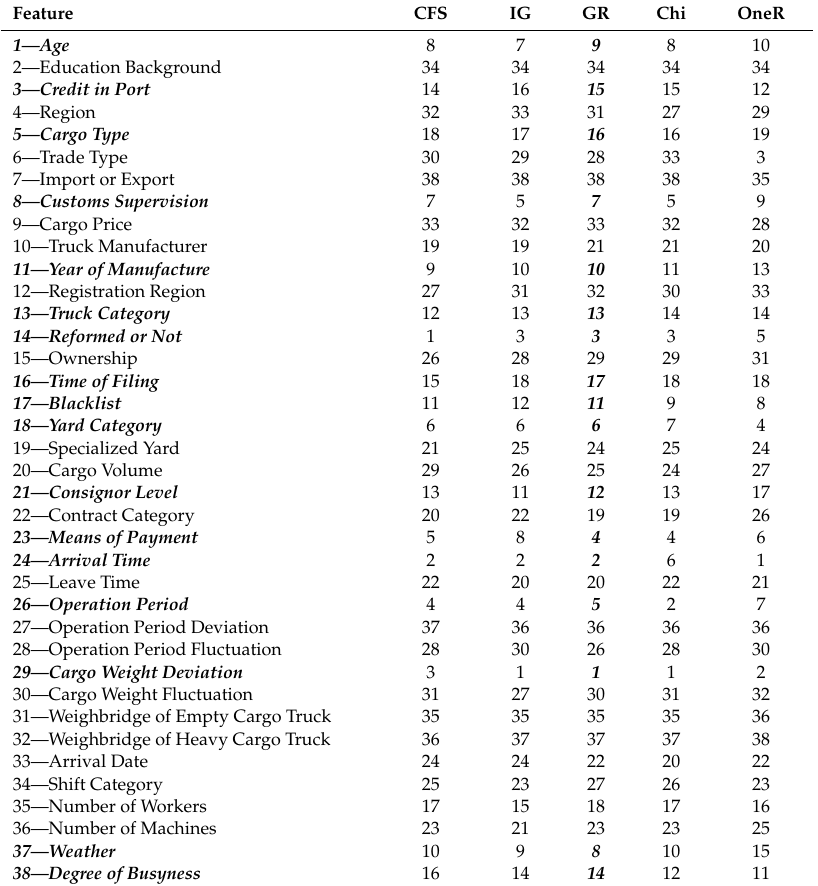
Table 3. Feature ranking